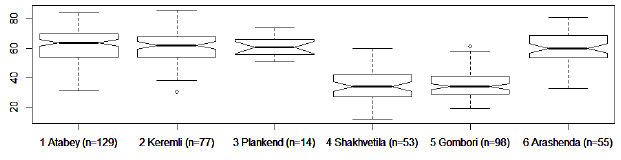
Fig. 5 . Box-and-whisker plots depicting the range of Pasture Degradation Index (PDI) values. Low PDI value indicates comparatively bad pasture